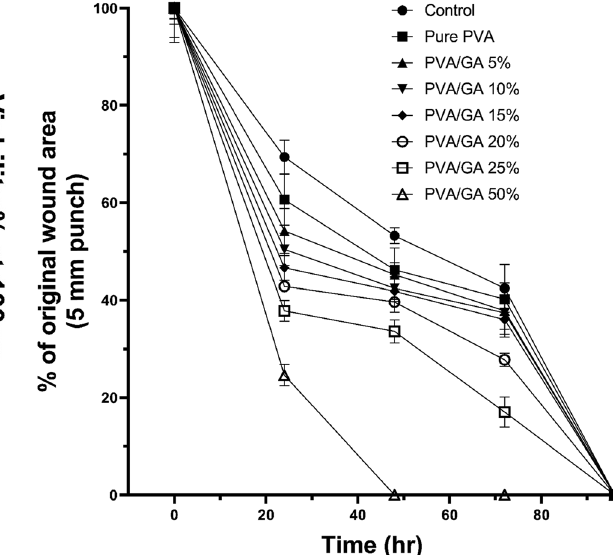
Figure 5: The cytotoxicity assessment of the pure PVA and the PVA/GA x hydrogels. Concentrations ( x ) of GA are from 5% to 50%.